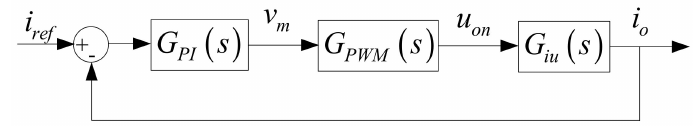
Figure 10. PR AC mode current control